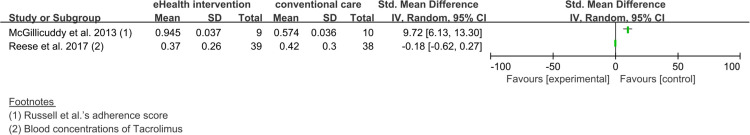
Forest plot without a pooled estimate demonstrating the effectiveness of eHealth interventions for medication adherence in organ transplant patients.The two studies presented here used objective methods to measure medication adherence in organ transplant patients and presented the results as continuous data.